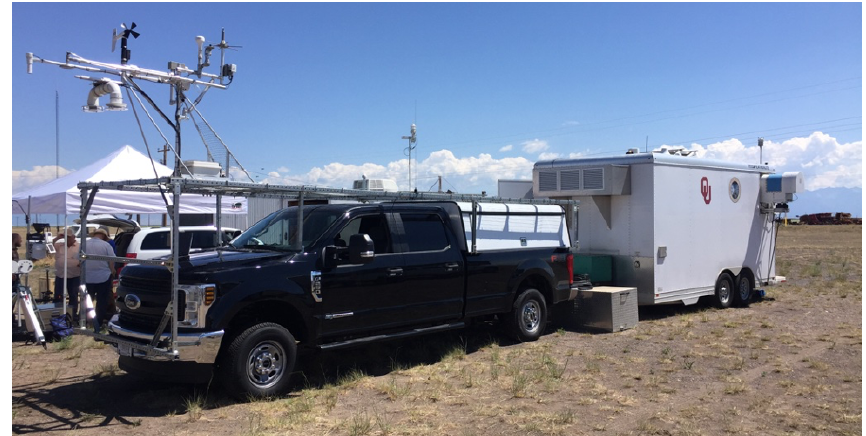
Figure 2. The NSSL MM as deployed during the LAPSE-RATE project. The trailer is the University of Oklahoma CLAMPS system (see Bell et al., 2020, in this special